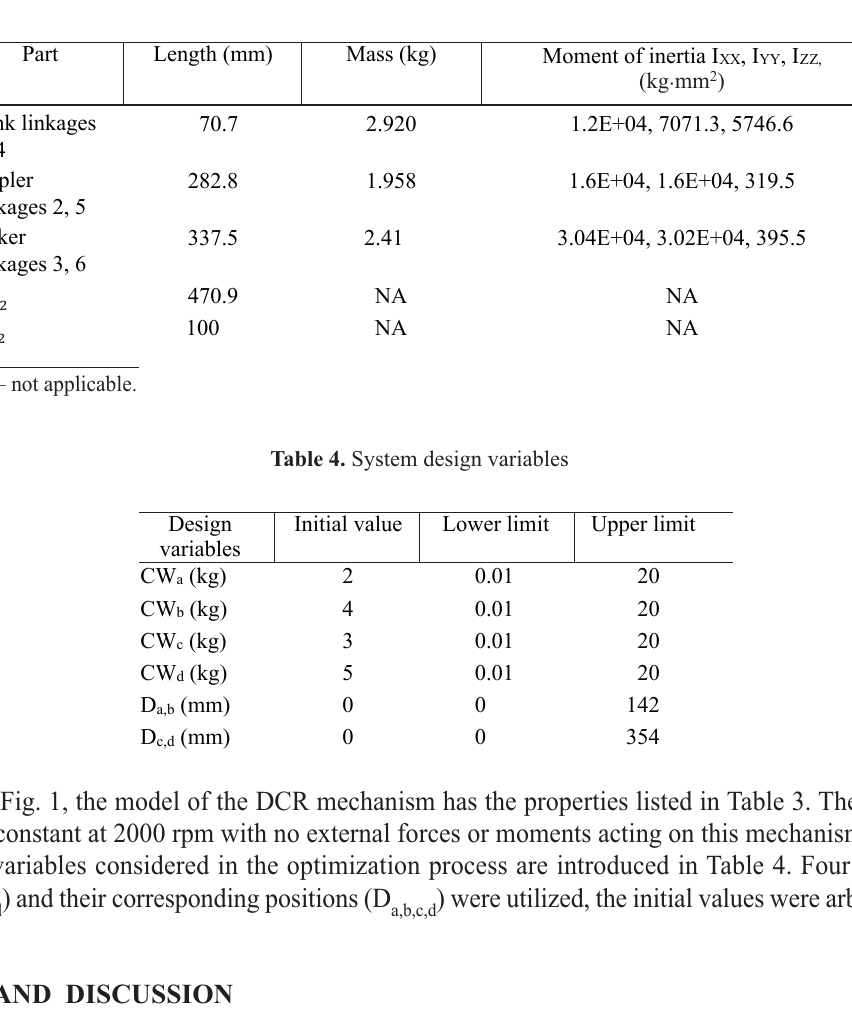
Table 3. DCR mechanism specifications